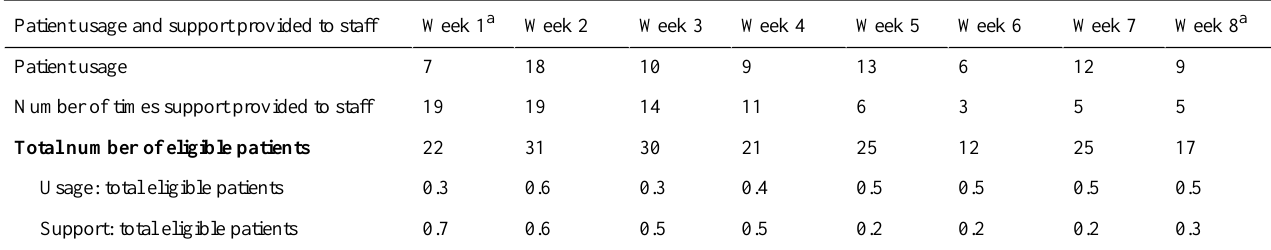
Table 1. Check Up GP rates of patient usage and support provided to staff and ratios of usage and support provided to total number of eligible